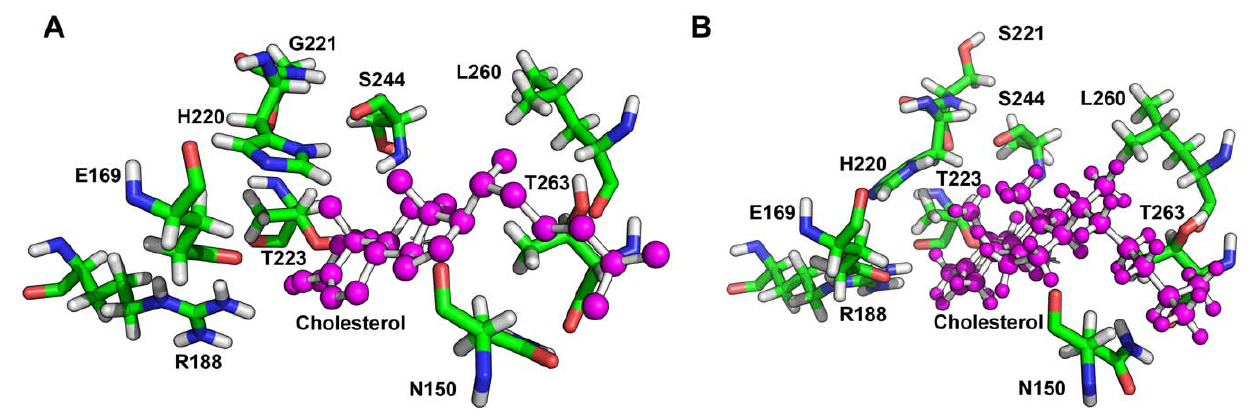
Figure 4. A closeup of the cholesterol binding pocket of StAR. After docking of cholesterol to both WT (A) and S221-StAR (B), we calculated potential residues interacting with cholesterol molecule during docking as well as exit of cholesterol from the binding cavity. In case of S221-StAR a loss of interaction with H220 was observed due to a shift in the H220 side chain. Cholesterol is shown as a ball and stick model in magenta. Amino acids interacting with cholesterol are shown as stick models.